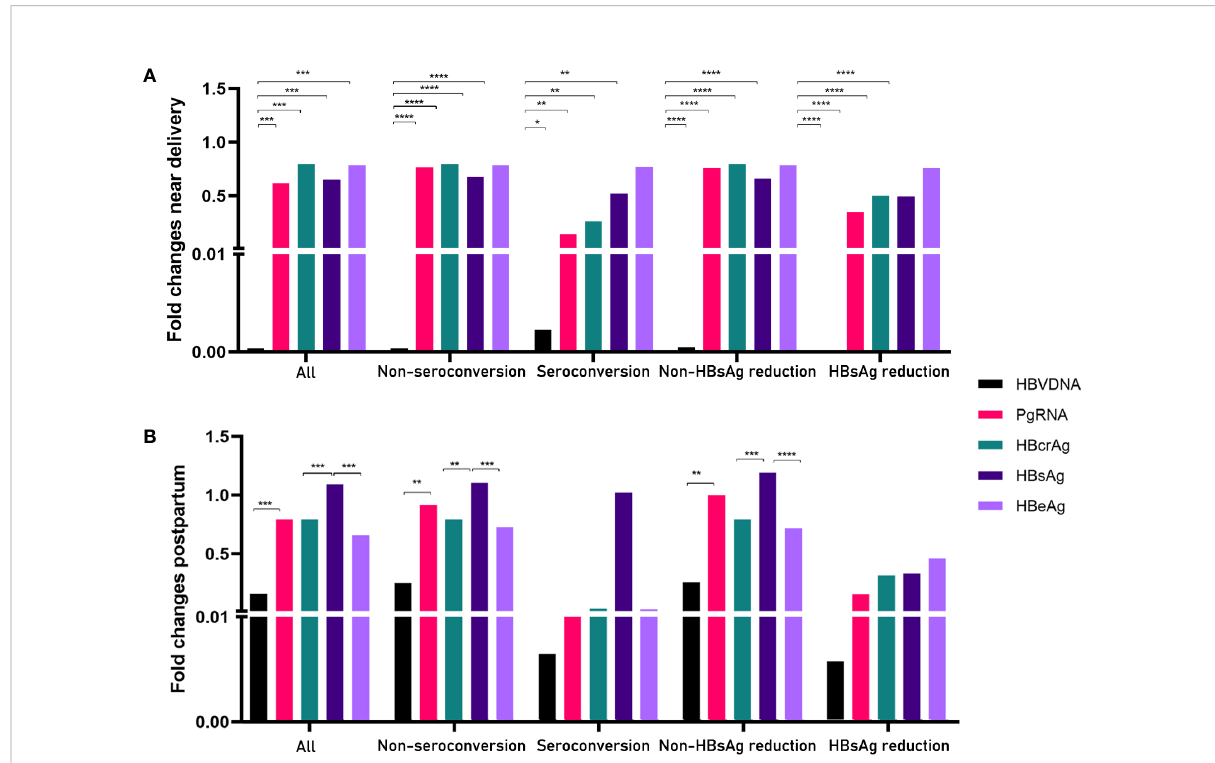
FIGURE 3 Comparisons of fold changes near delivery (A) and postpartum (B) in fi ve groups. *= p < 0.05, **= p < 0.01, ***= p < 0.001, ****= p < 0.0001.